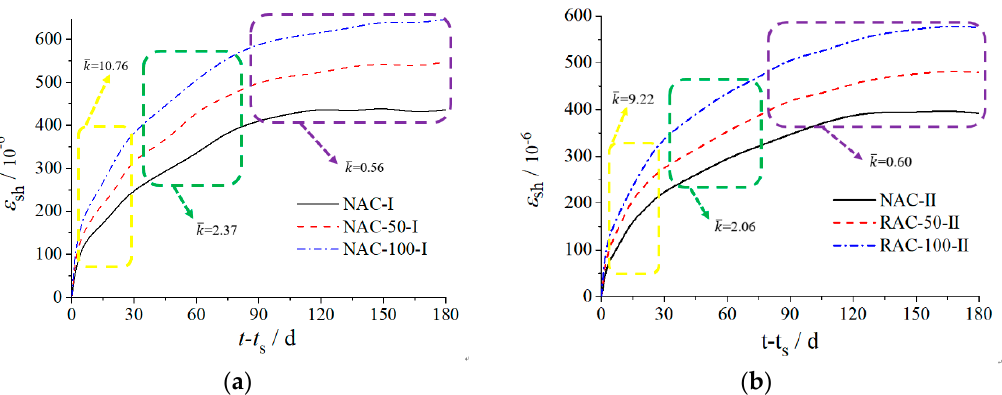
Figure 2. Shrinkage deformation curve of RAC with different water–cement ratios. ( a ) w/c = 0.527; ( b ) w/c = 0.4. Note: ε sh indicates shrinkage strain and is dimensionless; k indicates the slope and is dimensionless; t s indicates the age of the concrete at the start of drying; t indicates the age of the concrete.